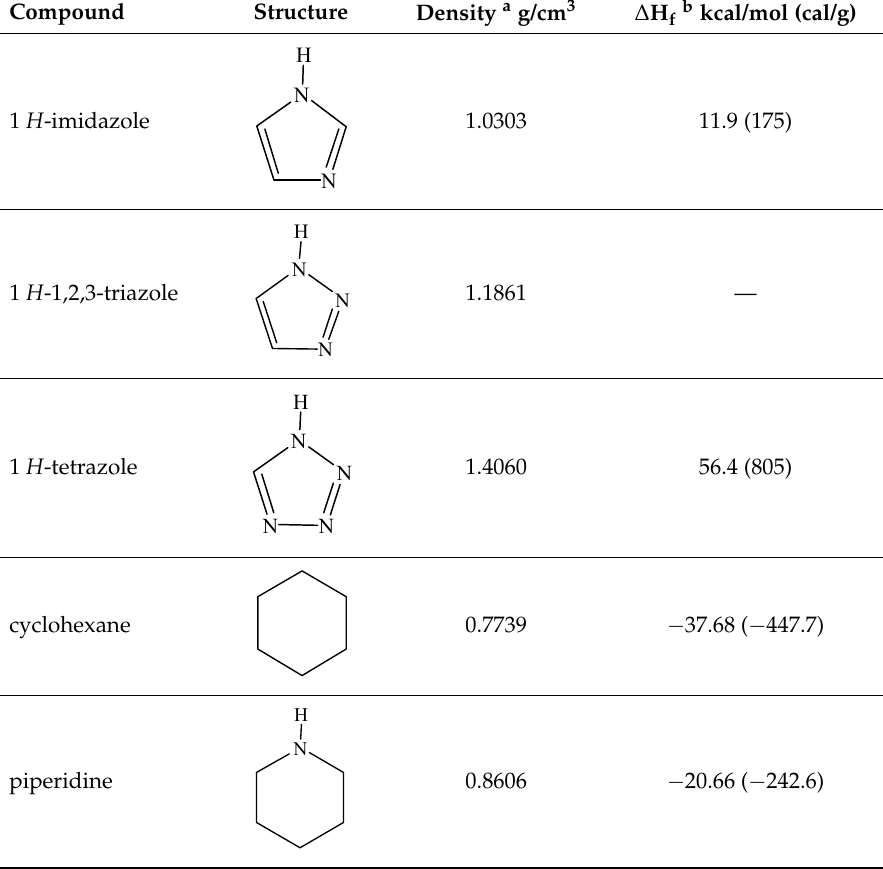
f . Table 4. Some experimental densities and heats of formation, Δ H f